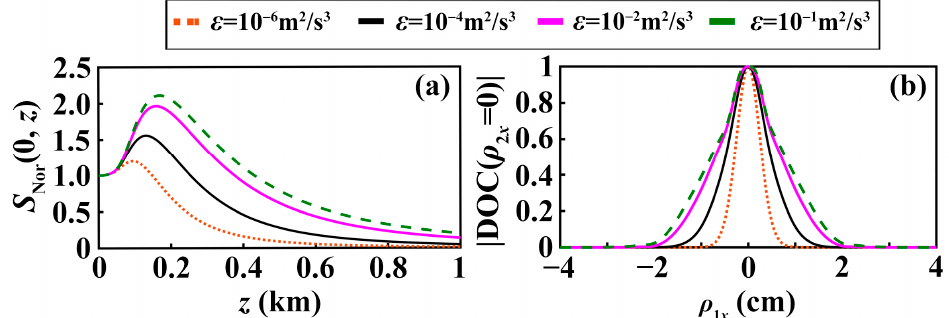
Figure 6. ( a ) Normalized on ‐ axis intensity of LNUC beams propagating in oceanic turbulence and ( b ) the cross ‐ line ( ρ 2 x = 0) of the absolute value of the spectral DOC at z = 150 m for different rates of dissipation of kinetic energy per unit mass of fluid.